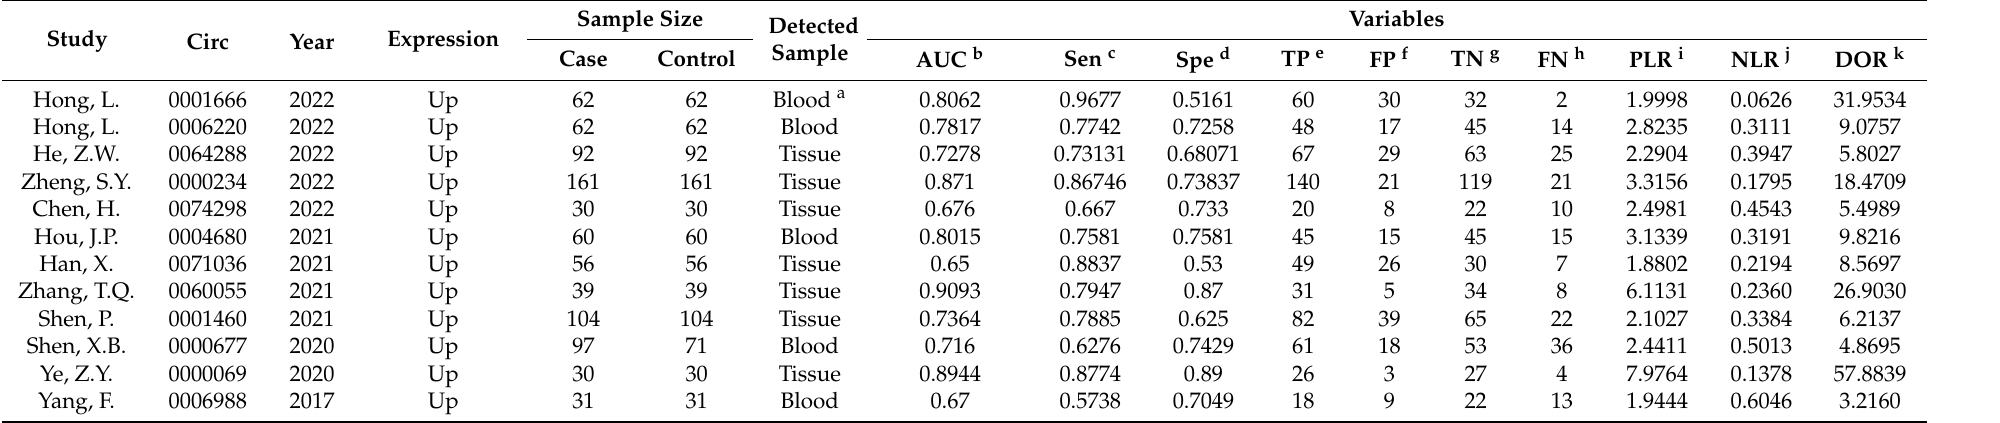
Table 2. Characteristics of diagnostic studies included in the